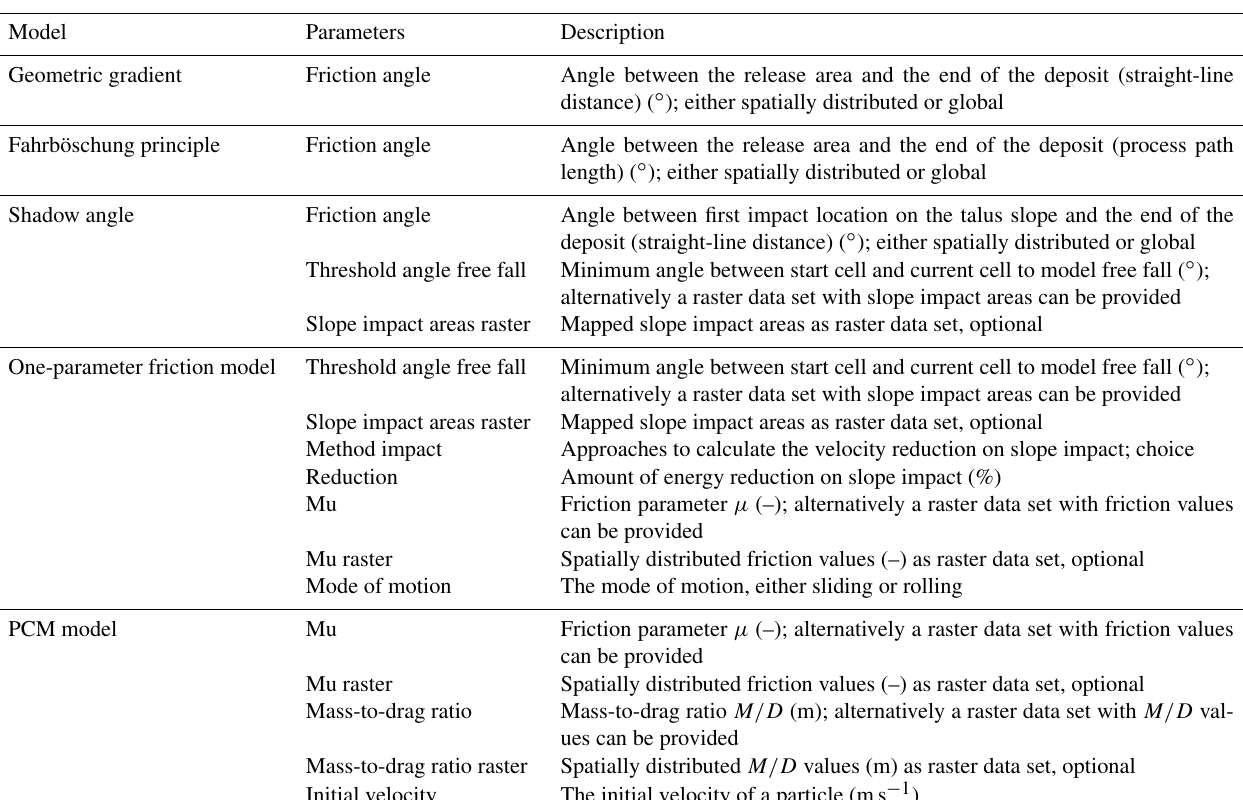
Table A2. The run-out parameters of the GPP